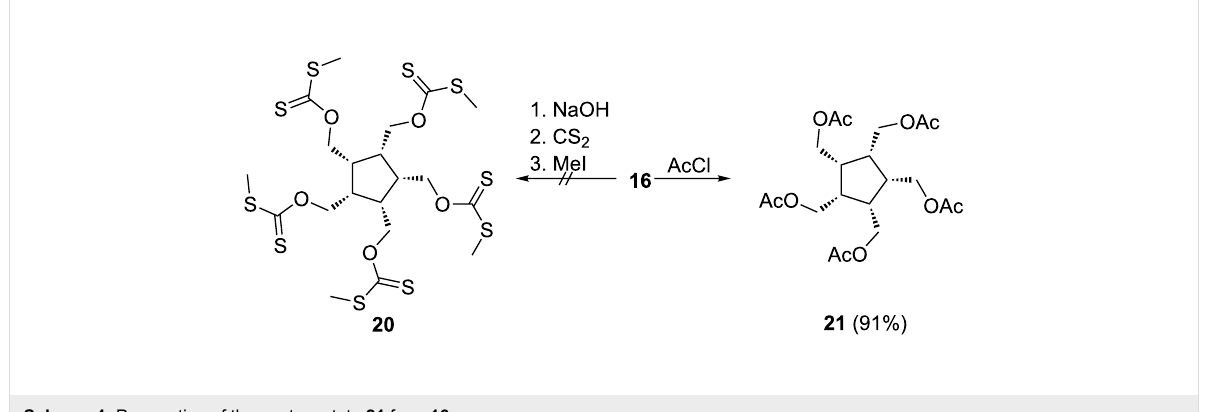
Scheme 4: Preparation of the pentaacetate 21 from 16 .